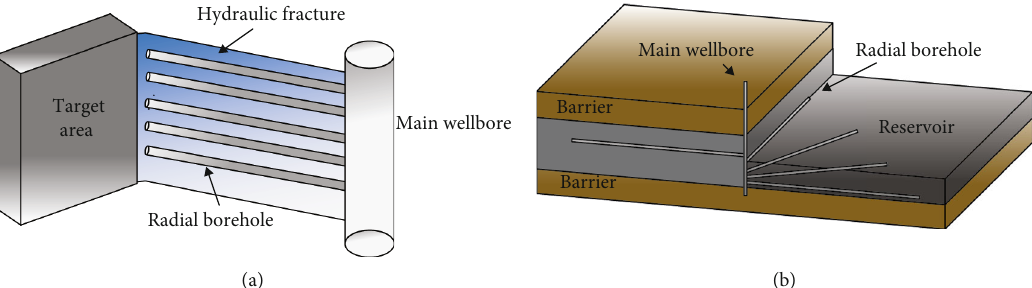
Figure 1: The layout pattern of radial boreholes. (a) Hydraulic fracturing guided by vertical multi-radial boreholes. (b) Tree-type hydraulic